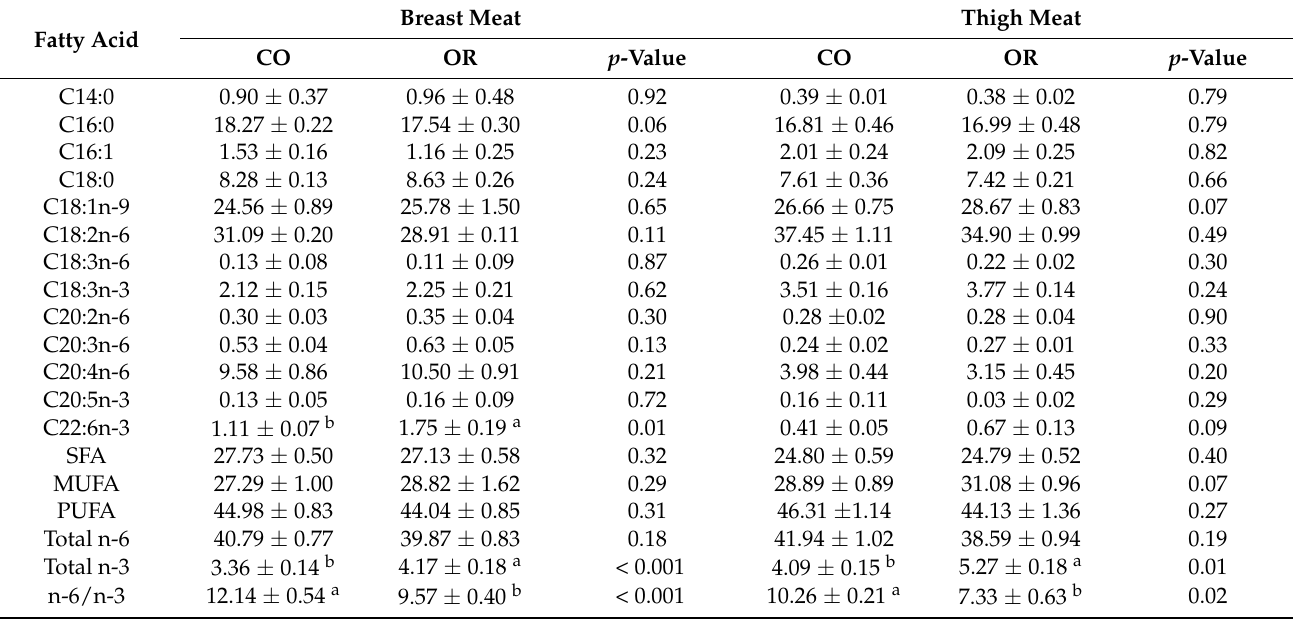
Table 7. Major fatty acid profiles (g/100 g total FA) of skinless breast and thigh meat from organic chickens (mean ±